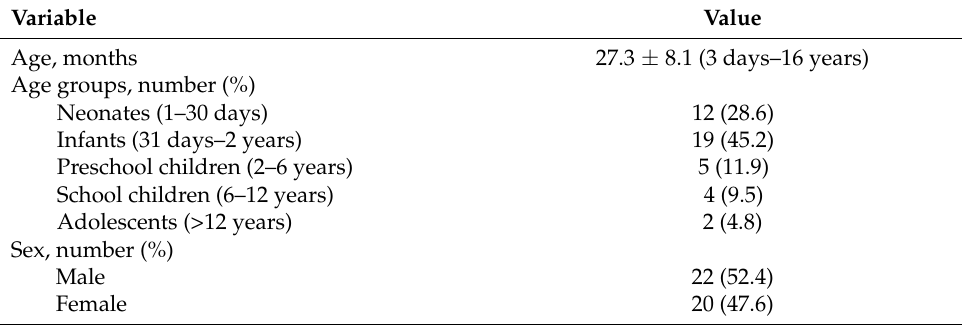
Table 2. Demographic data of the